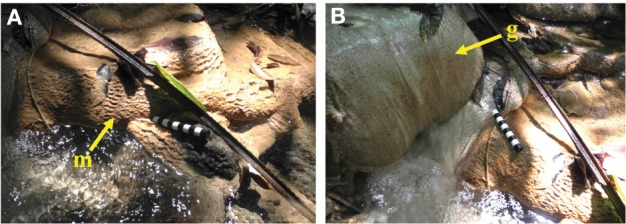
Terrace formation at CC1. (A) Terraces range in scale from mm (microterracette, m) to meters. Microterracettes form evenly spaced ridges along the rims of the larger, cm-sized terracettes. Scale bar equals 10 cm. (B) Serpentinizing fluid flowing over gabbro forms a mound-like feature (g). Scale bar equals 10 cm.